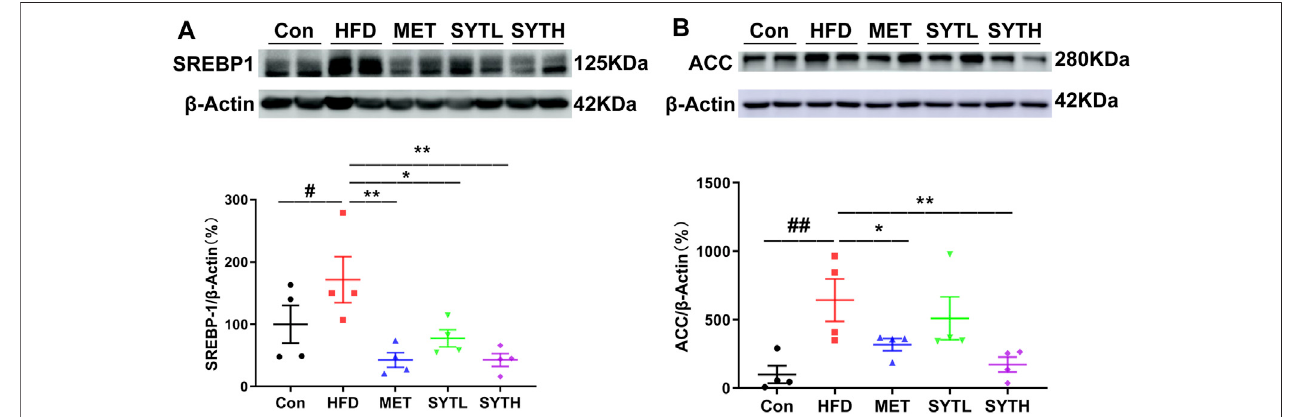
FIGURE 6 | SYT downregulates protein levels of SREBP1 and ACC in HFD mice. After treatment with SYT for 20 weeks, liver tissues were obtained from all the mice. Protein levels of SREBP1 (A) , ACC (B) in the liver tissues were detected by western blot. # p < 0.05, ## p < 0.01 compared with Con group; * p < 0.05, ** p < 0.01 compared with HFD